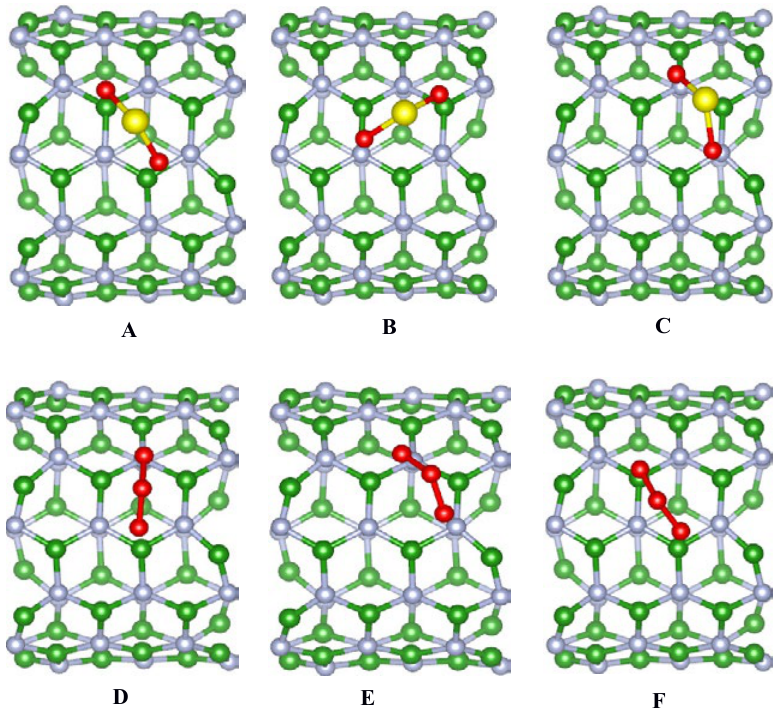
Fig. 1. Optimized geometry configurations of SO Figure 1. Optimized geometry configurations of SO 2 and O 3 molecules adsorbed on the boron nitride (BN) nanotubes.